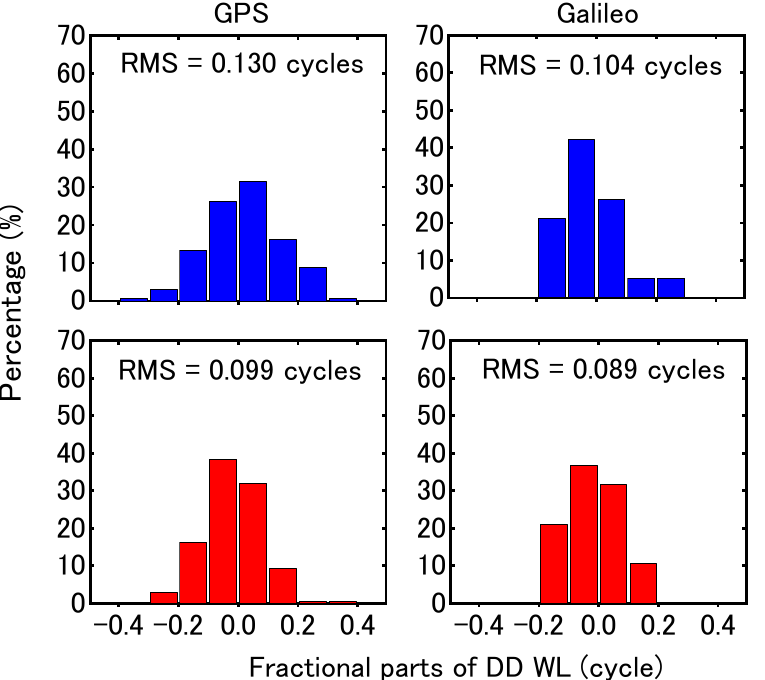
Figure 8. Histogram distribution of the fractional parts of DD WL ambiguities for long baseline MAR6_ZIM2 on DOY 101, 2019, without ( top row ) and with ( bottom row ) receiver-related pseudorange biases correction.